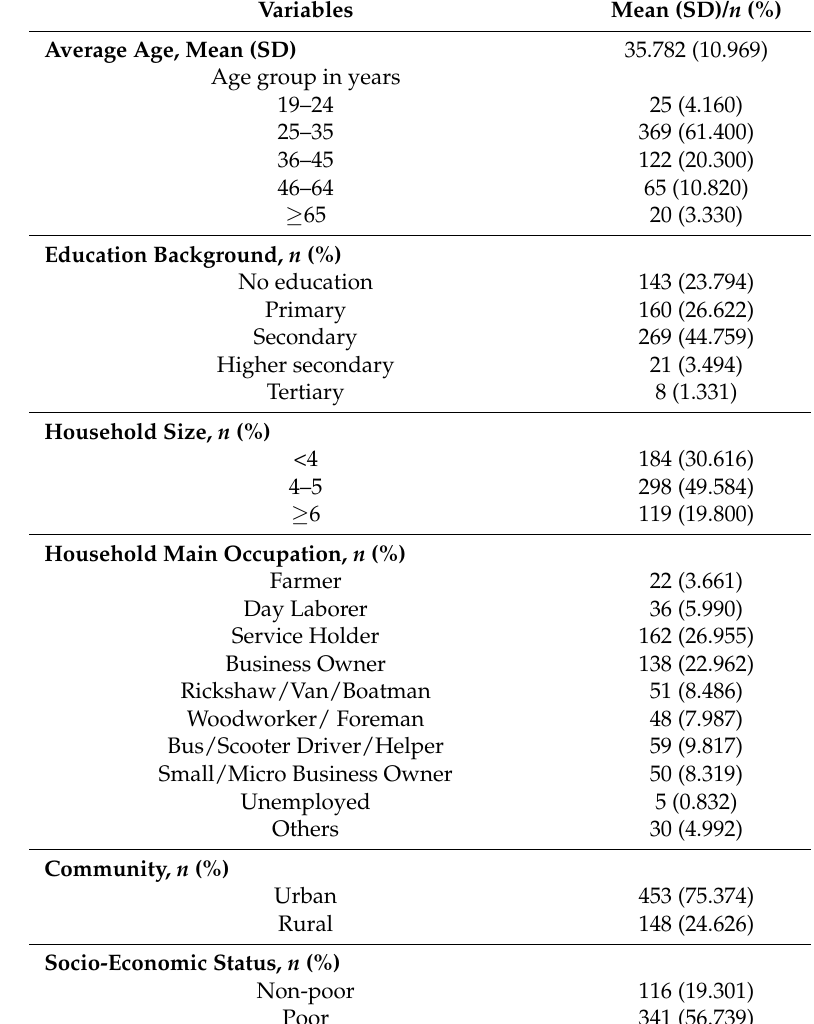
Table 2. The background characteristics of the discrete choice experiment (DCE) study participants ( N =